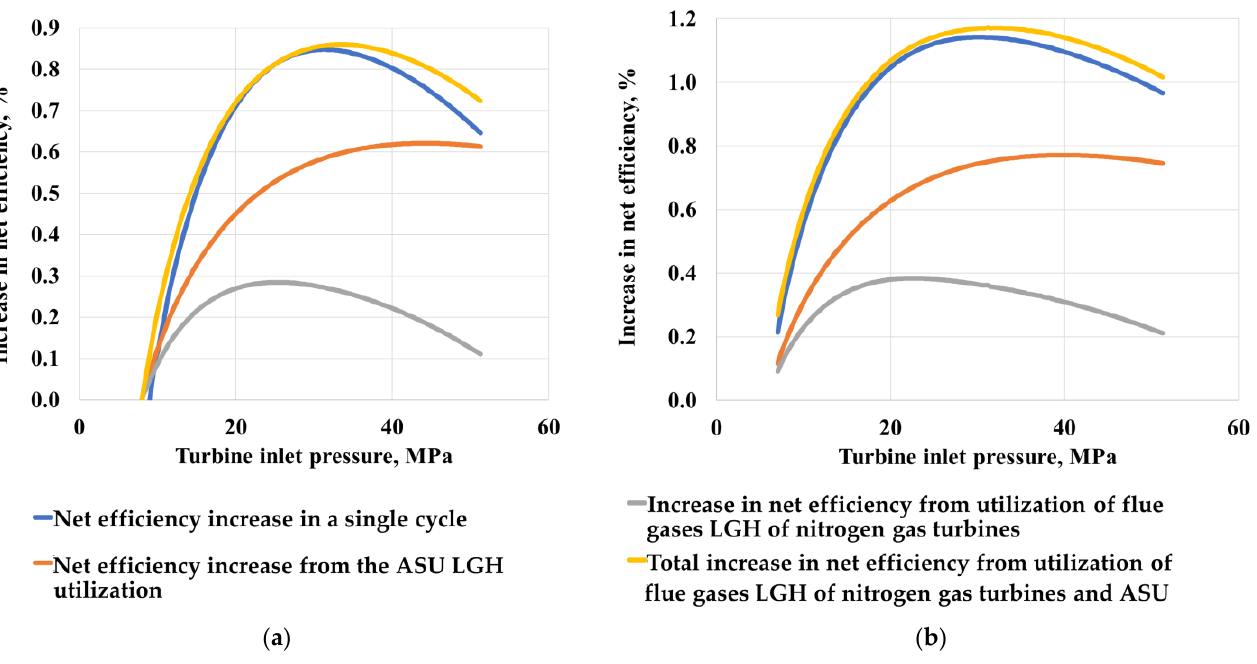
Figure 8. The increase in the efficiency of the Allam cycle with coal gasification when using the Brayton cycle ( a ) and the Rankine cycle ( b ). Brayton cycle ( a ) and the Rankine cycle ( b